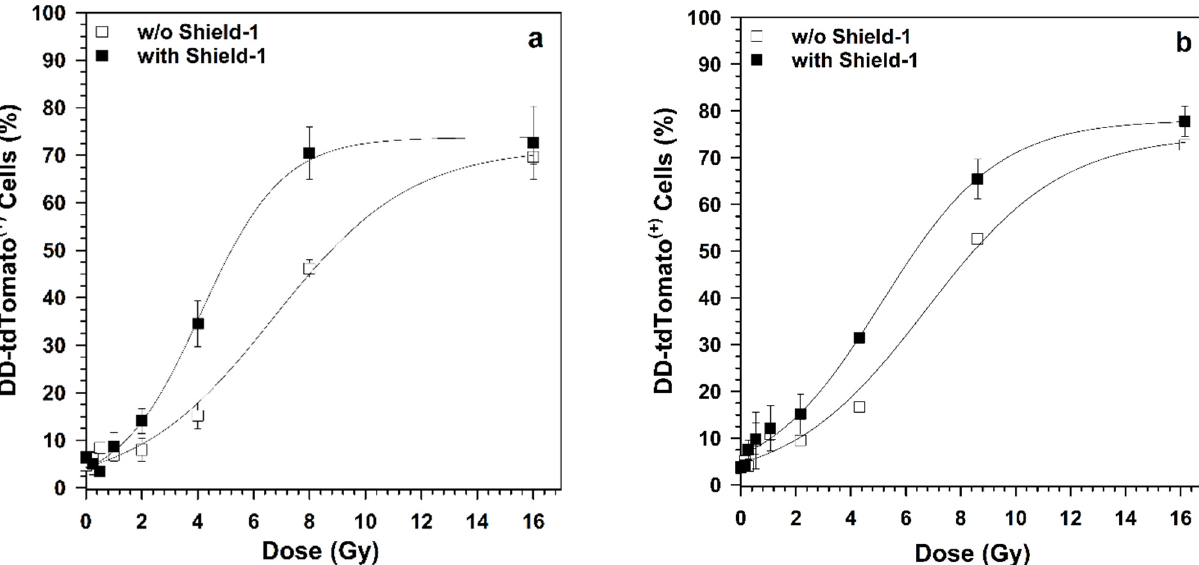
Figure 4. Effect of Shield-1 on NF- κ B-dependent DD-tdTomato expression. HEK-pNF κ B-DD-tdTomato-C8 cells were fixed 18 h after exposure to ( a ) 12 C ions (LET 51 keV/ µ m) and ( b ) 36 Ar ions (LET 272 keV/ µ m) in the absence and presence of Shield-1. NF- κ B-dependent DD-tdTomato expression was determined using flow cytometric analysis. The percentage of DD-tdTomato positive cells (DD-tdTomato(+)) was determined from the red fluorescence histograms (see Supplementary Figure S1) and plotted as mean ± SD ( n = 2).